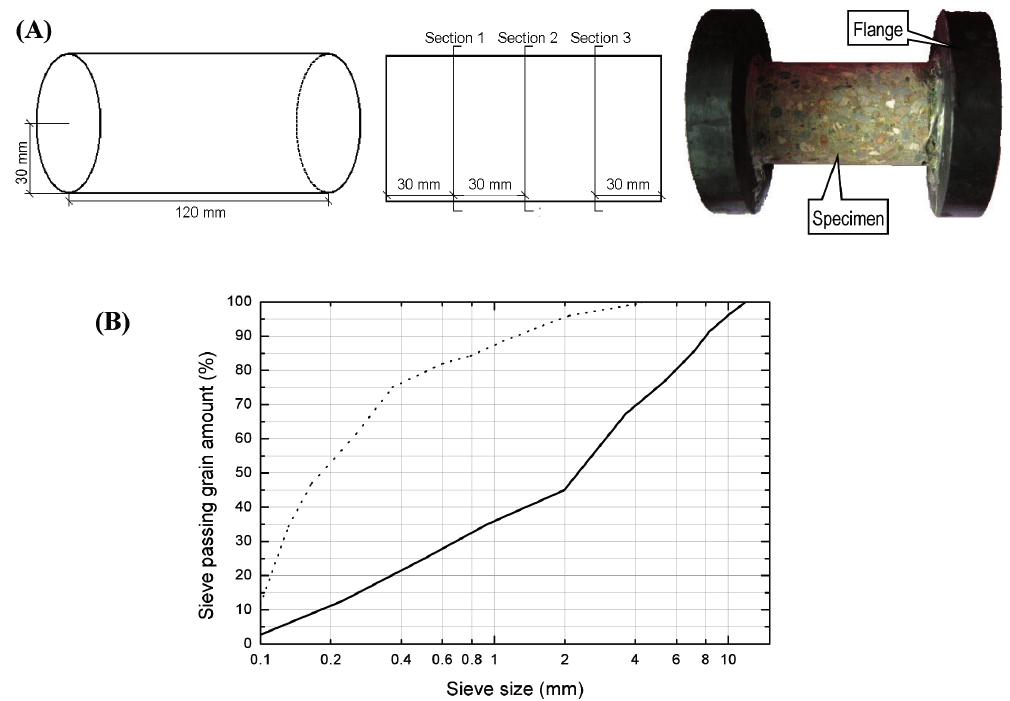
Fig. 2. Geometry of the experimental concrete specimen: a) geometry (left), section position (middle) and photograph (right); b) grading curve for sand (discontinuous line) and gravel (continuous line) used for the concrete